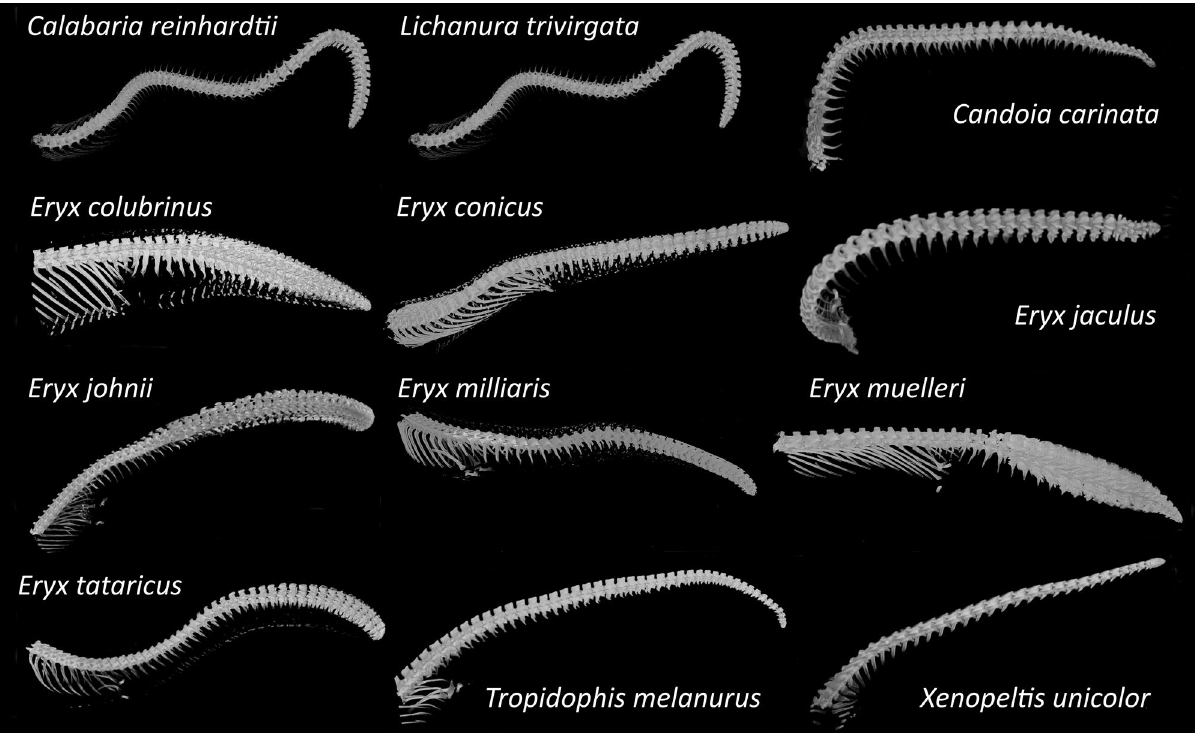
Figure 3. Caudal and tail morphology of studied snakes as revealed by µCT. Note small osteoderms visible in E. colubrinus , E. conicus , E. miliaris and E. tataricus. Caudal vertebrae modifications are apparent in all species of Eryx except E. jaculus . Author: Petra Frýdlová and Jana Mrzílková.